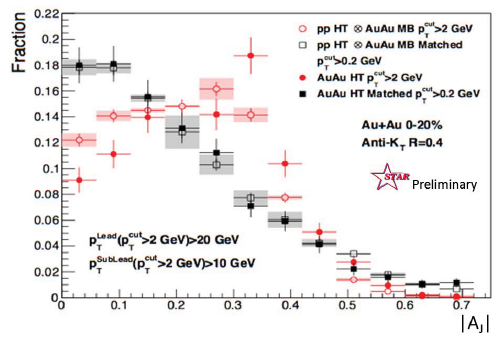
Figure 2. (Color online) Dijet p T imbalance in central AA and pp collisions [7]. Jets are reconstructed by the anti- k T algorithm with R = 0 . 4, and particle p T > 2GeV / c (red points). Results with the same dijets but including p T > 0 . 2GeV / c particles in jet energy are shown in